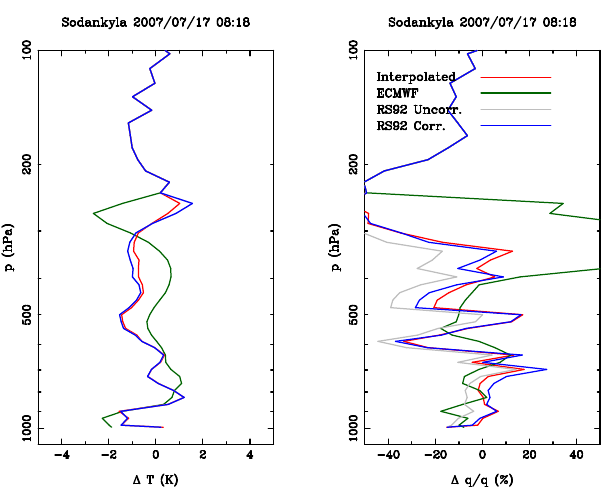
Figure 2. Difference of the reference profiles minus the OE re- trieval.